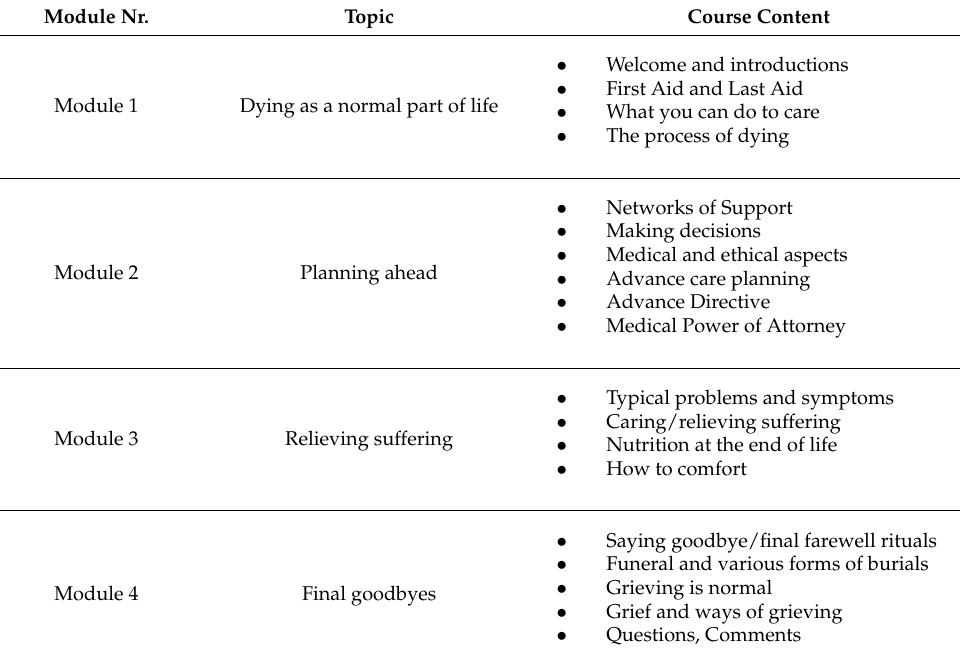
Table 1. The Last Aid course contents (actual version updated